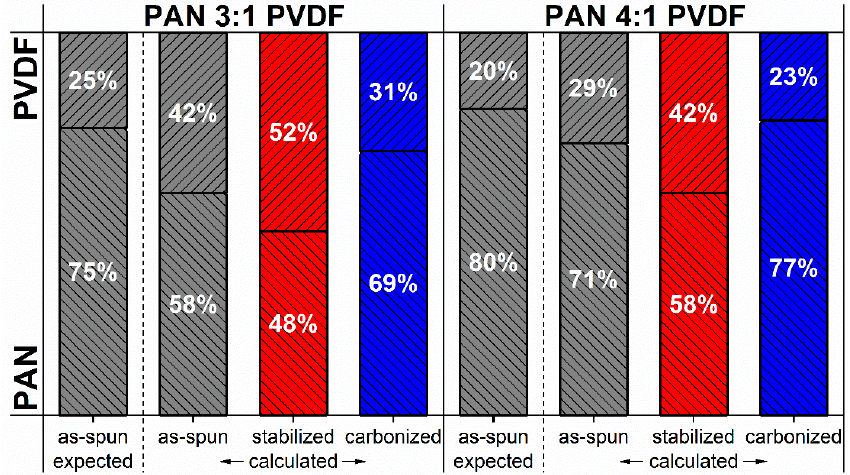
Figure 5. Calculated polymer mass ratios of blend nanofibers based on TGA measurements compared to the mass ratios that would be expected due to the polymer concentrations in the spinning-solutions.